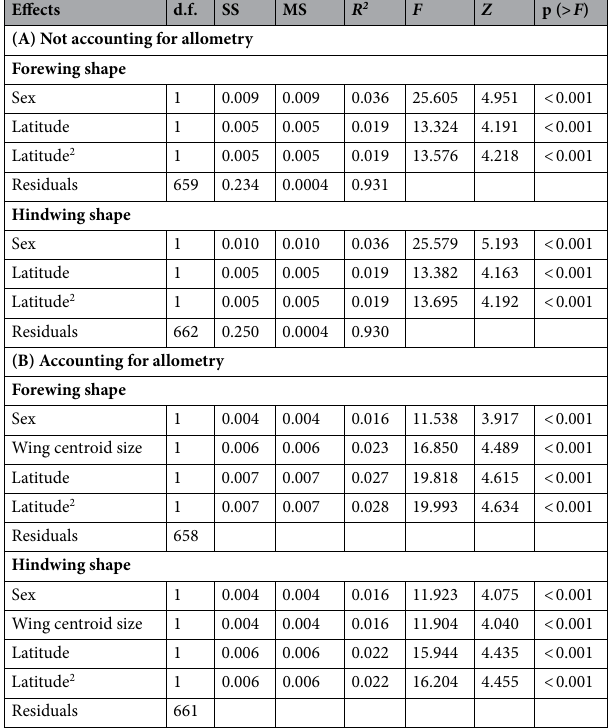
petiole than male wings (Fig. 4, Supplementary Fig. S2). The deformation grids regarding wing shape variation along latitude are not shown since the wing shape variation was almost imperceptible. When the allometry of wing shape was accounted for by incorporating wing centroid size in the Procrustes ANOVAs (Table 3B), neither sex, latitude nor wing centroid size explained more than 5.5% of the total wing shape variation. Wing shape variation in relation to wing centroid size was subtle, with small wings showing a more pedunculated shape, broader tip, longer petiole and narrow wing base, and large wings showing a thicker shape with shorter petiole and broad base (Fig. 5).